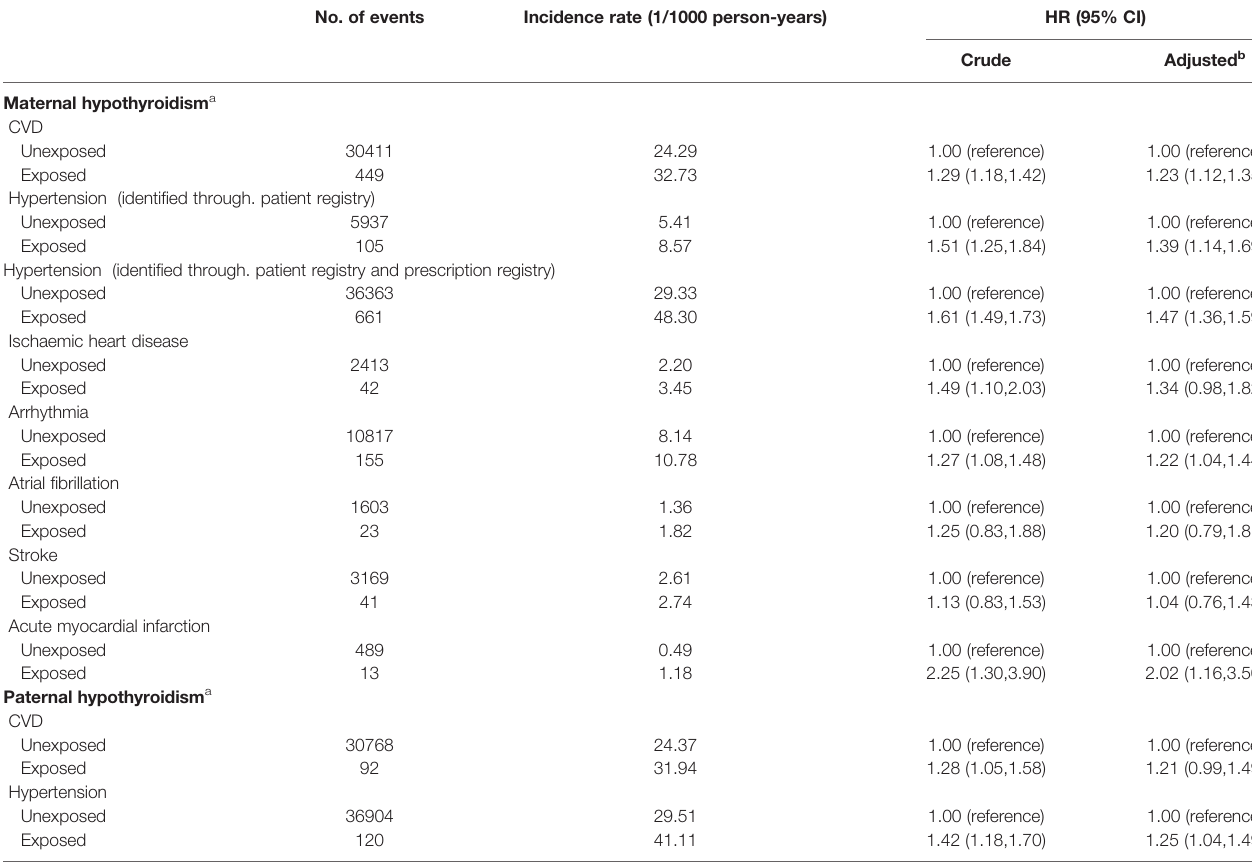
TABLE 2 | Hazard ratios and 95% con fi dence intervals for offspring ’ s CVD according to exposure of maternal and paternal